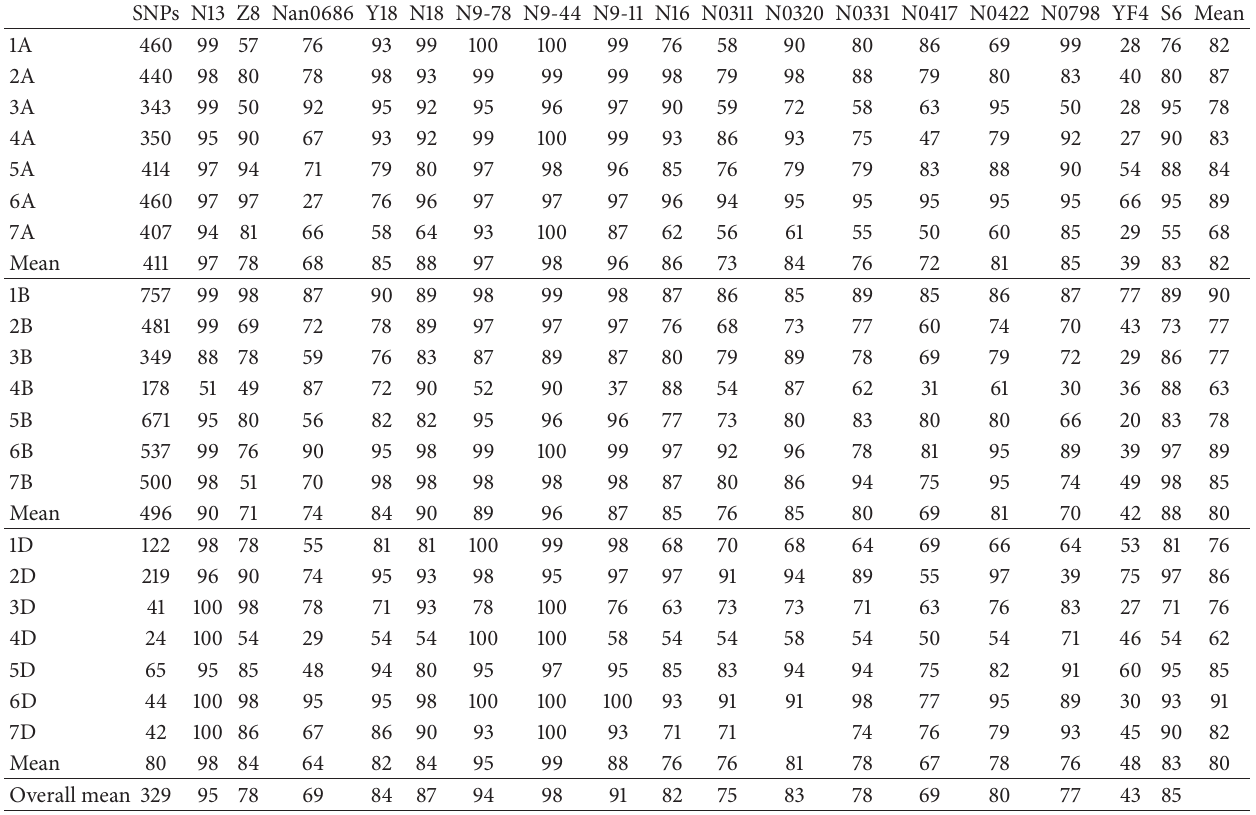
Table 3: Same allele ratios (SAR) between Ningmai 9 and its derivatives on 21 chromosomes